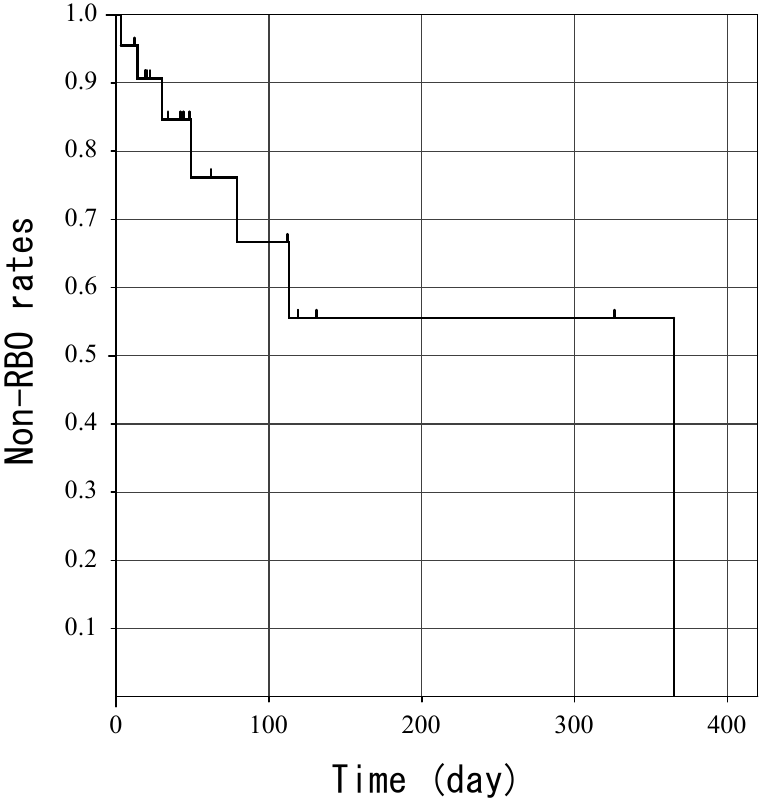
Figure 6. Kaplan–Meier curve of time to recurrent biliary obstruction. The small vertical bars indicate censored patients.